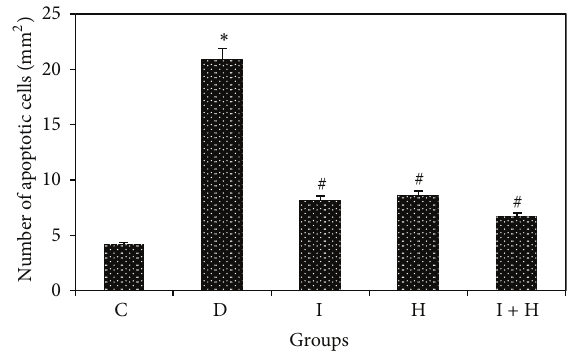
Figure 4: Effects of insulin and honey on apoptosis of neuronal cells in the hippocampus of rats in each group (12 rats in each group). Bar graph indicates the mean ± SD. # 𝑃 < 0.0001 ; ∗ 𝑃 ≤ 0.01 compared to the control group C; # 𝑃 < 0.001 compared to the diabetic group